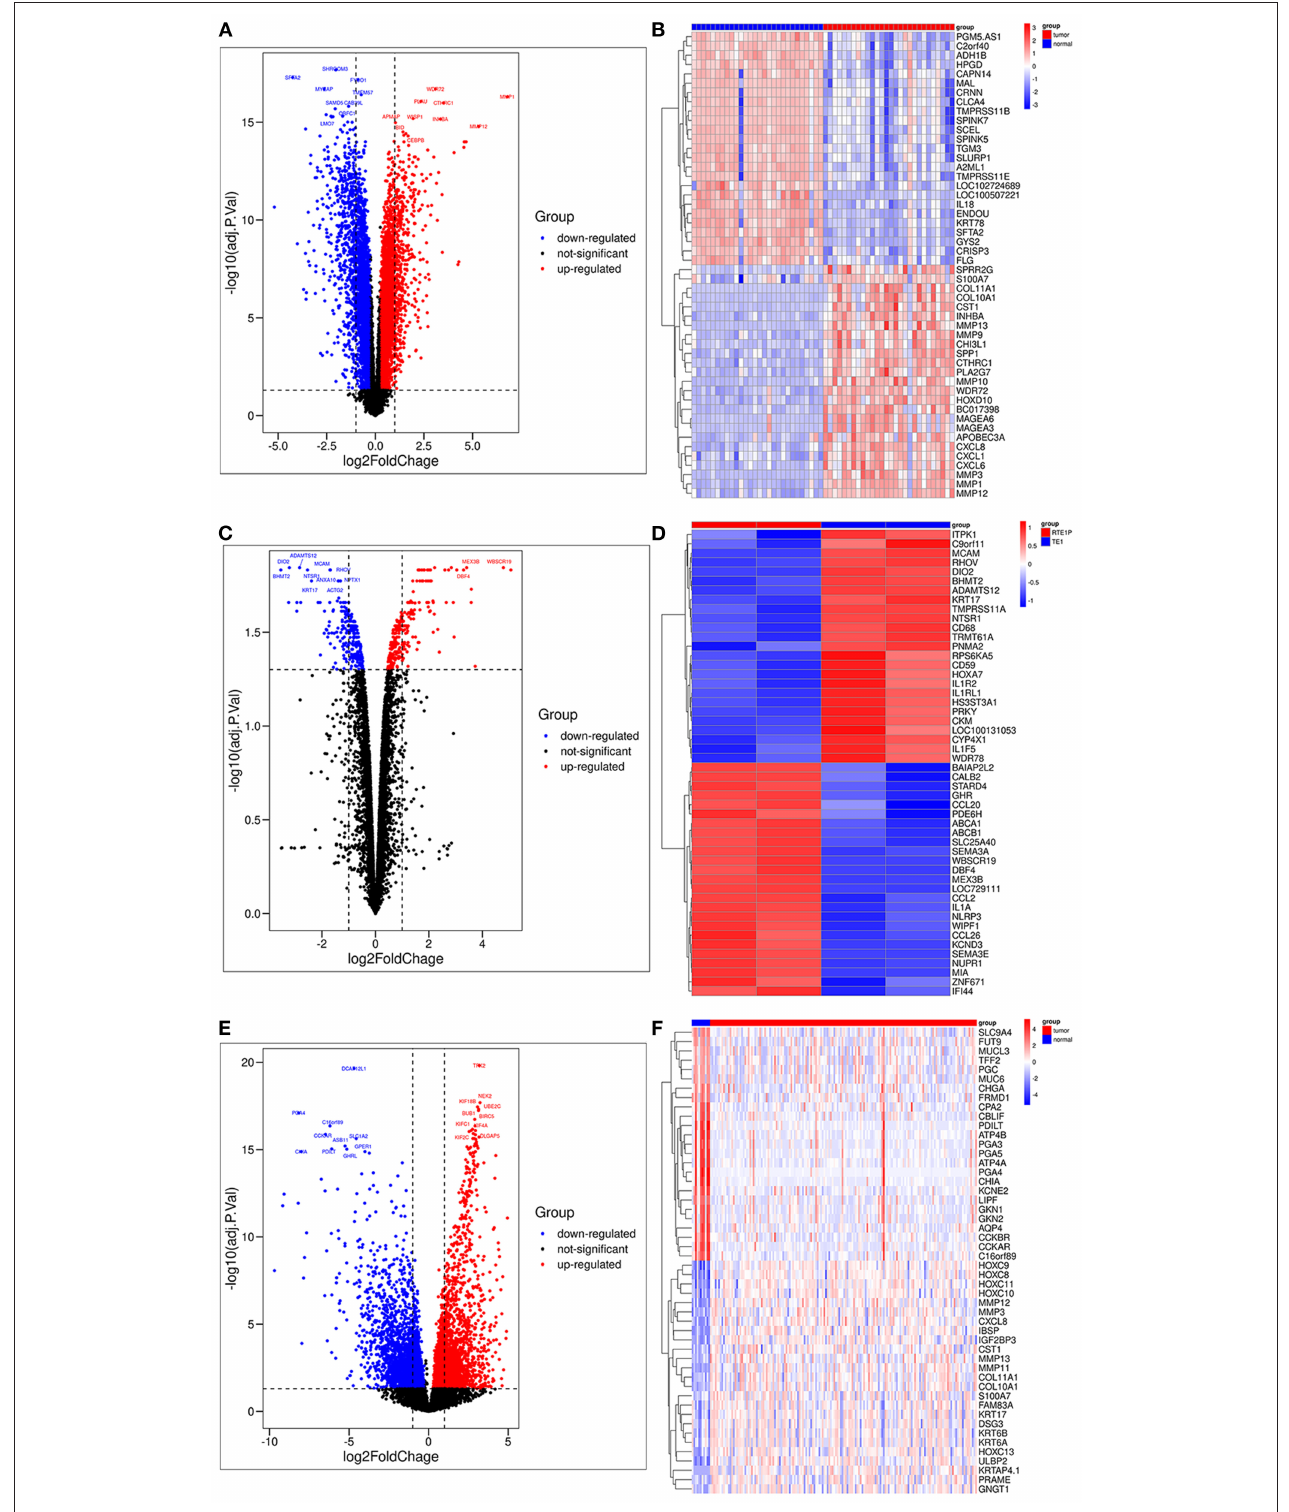
FIGURE 1 | Volcano plot and heatmap of the differentially expressed genes in the GSE161533, GSE86099, and The Cancer Genome Atlas Esophageal Carcinoma (TCGA-ESCA) datasets. (A) Volcano plot of GSE161533 with the top 10 significant genes in the upregulated and downregulated clusters (ranked by p adj.